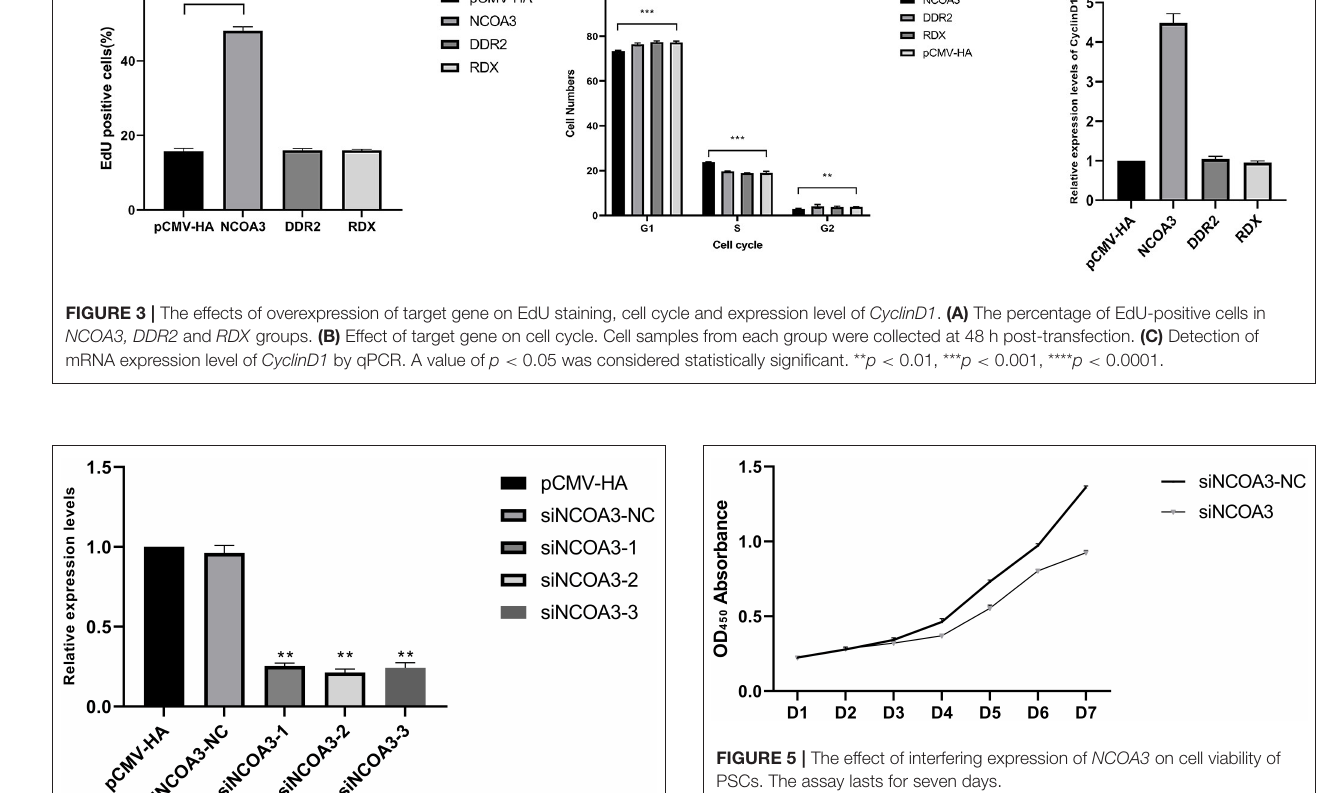
was considered statistically significant and P < 0.01 ( ∗∗ P <